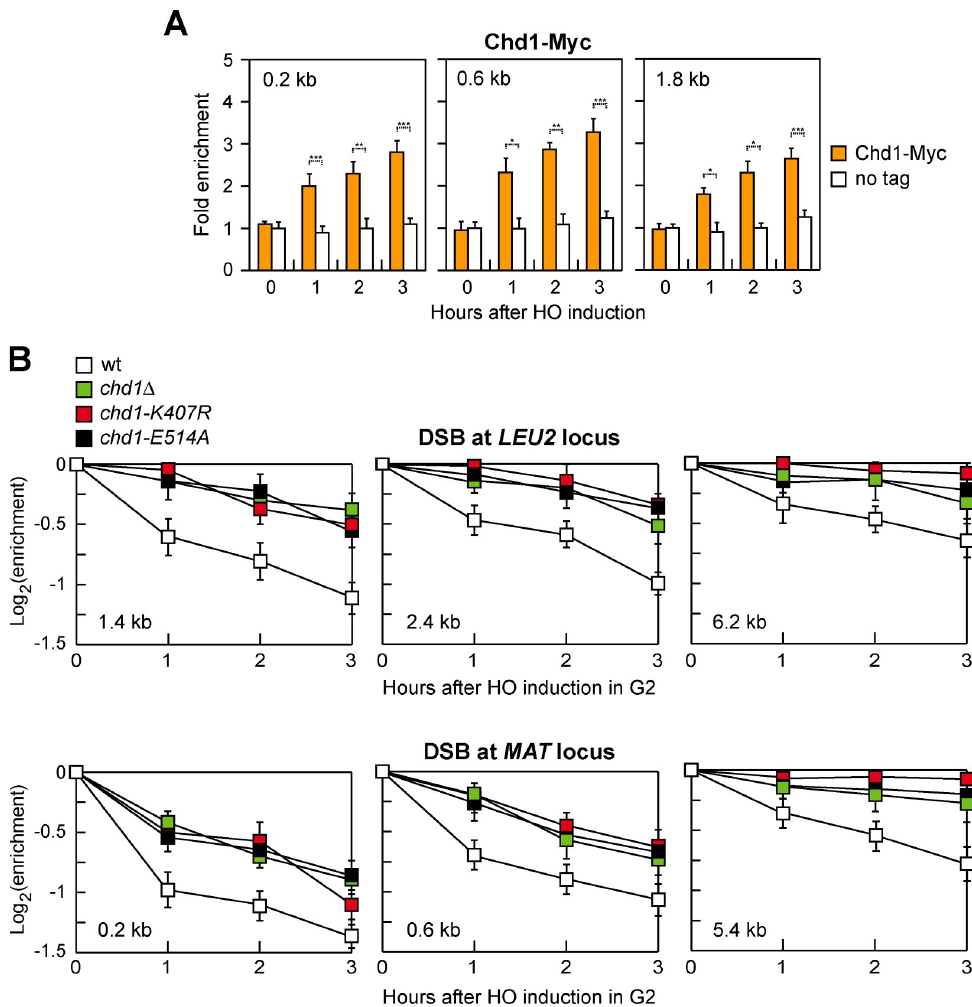
Fig 1. Chd1 recruitment to a DSB and histone removal. (A) Exponentially growing YEPR cell cultures of JKM139 derivative strains were transferred to YEPRG, followed by Chd1-Myc ChIP at the indicated distances from the HO-cut site compared to untagged Chd1 (no tag). Data are expressed as fold enrichment at the HO-cut site over that at a non- cleavable locus ( ARO1 ), after normalization to the corresponding input for each time point. Fold enrichment was then normalized to cut efficiency. Plotted values are the mean values ± s.d. from three independent experiments. ��� P < 0.005, �� P < 0.01, � P < 0.05, t- test. (B) HO expression was induced by galactose addition to G2-arrested cells carrying the HO system at the LEU2 or at the MAT locus. Cells were kept arrested in G2 by nocodazole throughout the experiment. Histone H3 ChIP with anti-H3 antibody at the indicated distances from the HO-cut site. Data are expressed as fold enrichment at the HO-cut site over that at the non-cleavable ARO1 locus after normalization to the corresponding input for each time point. Fold enrichment was normalized to cut efficiency. Plotted values are the mean values ± s.d. from three independent